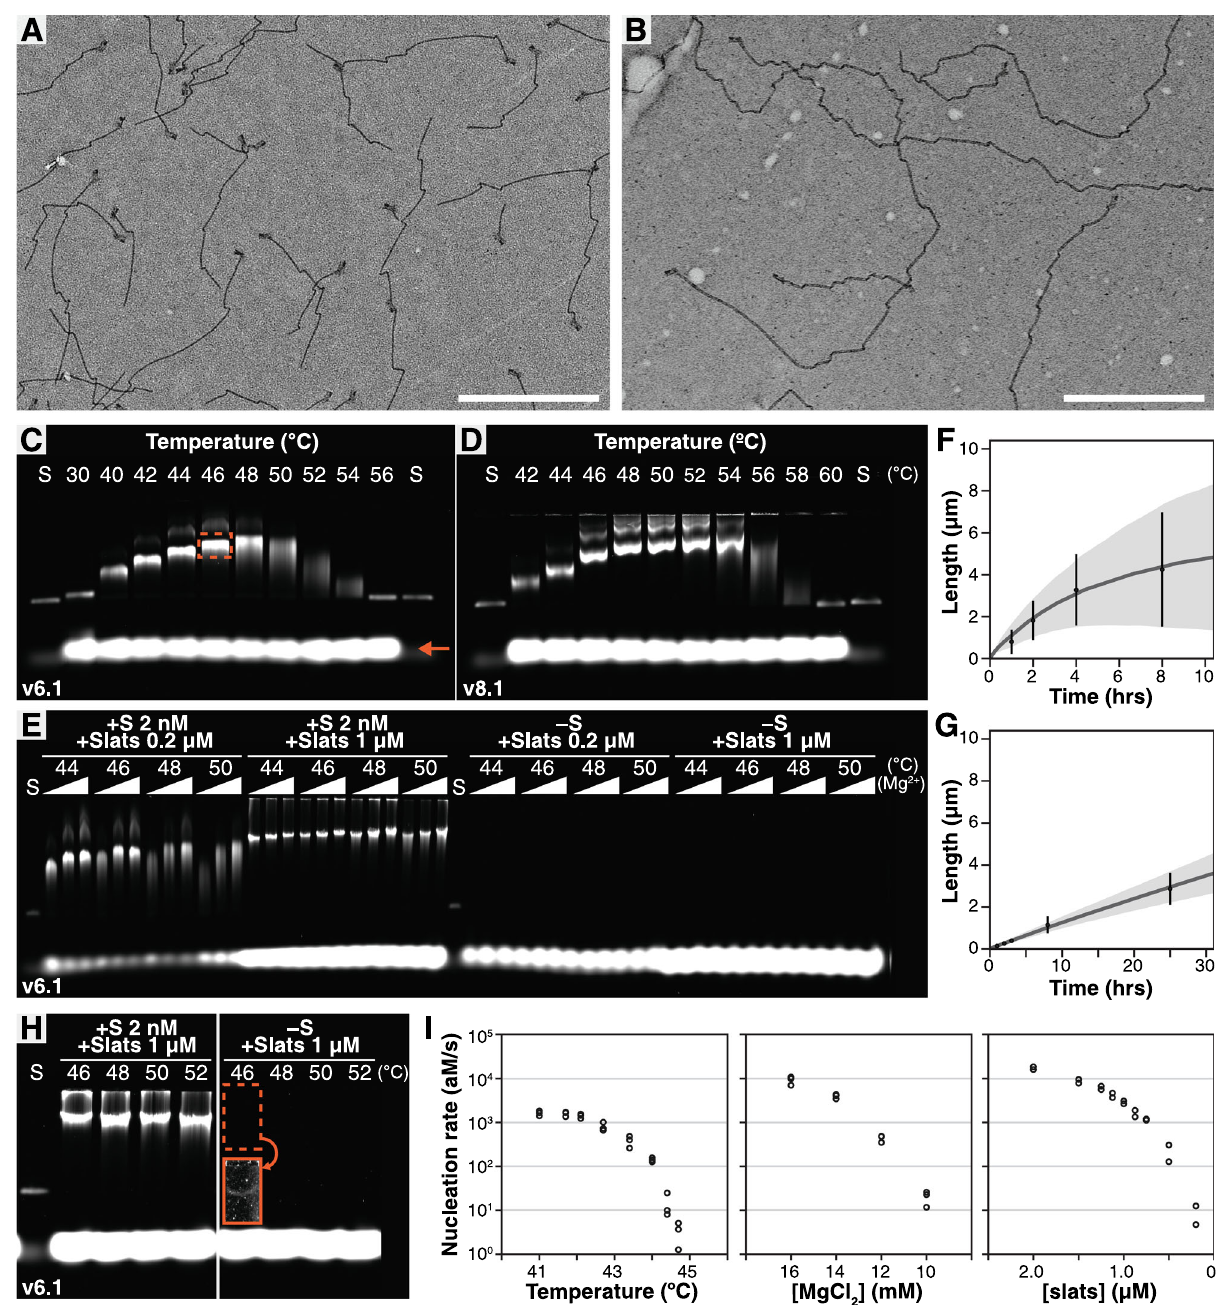
Fig. 3 Characterization of DNA slat assembly with and without the seed. Negative-stain TEM images of v6.1 ( A 2nM seed, 1 µ M each slat, 16mM MgCl 2 , and 50°C for 1h) and v8.2 ( B 2nM seed, 0.5 µ M each slat, 16mM MgCl 2 , and 50°C for ~16h) seeded ribbons, with 1 µ m scale bars. C , D Agarose gels of seeded v6.1 and v8.1 ribbons using 14mM MgCl 2 , 0.2 µ M each slat, and 2nM origami seed. Dotted orange boxes are ribbons, orange arrow points to unpolymerized slats (each slat is in 100-fold excess to the seed in the reaction), and “ S ” is the origami seed. E Agarose gel of v6.1 slats incubated ~16h (0.2 or 1 µ M each slat and 2nM origami seed), with the Δ showing 12, 14, or 16mM MgCl 2 . F , G Length of seeded v6.1 ribbons versus time from TEM for a fast-growth high temperature and a slow-growth low temperature, respectively. Data points are the mean±SD length ( F N 1h = 163, N 2h = 130, N 4h = 141, N 8h = 140; G N 1h = 155, N 2h = 168, N 3h = 154, N 8h = 161, N 25h = 151; with error bars obscured by data points). Gray interpolating lines are mean lengths from the stochastic model ( N = 150 ribbons, with shaded range ±SD). H Extended 100h incubation of v6.1 slats. I Rate of spontaneous nucleation versus reaction parameters for v6.1. Results are representative of three independent experiments for temperature and MgCl 2 , and two independent experiments for slat